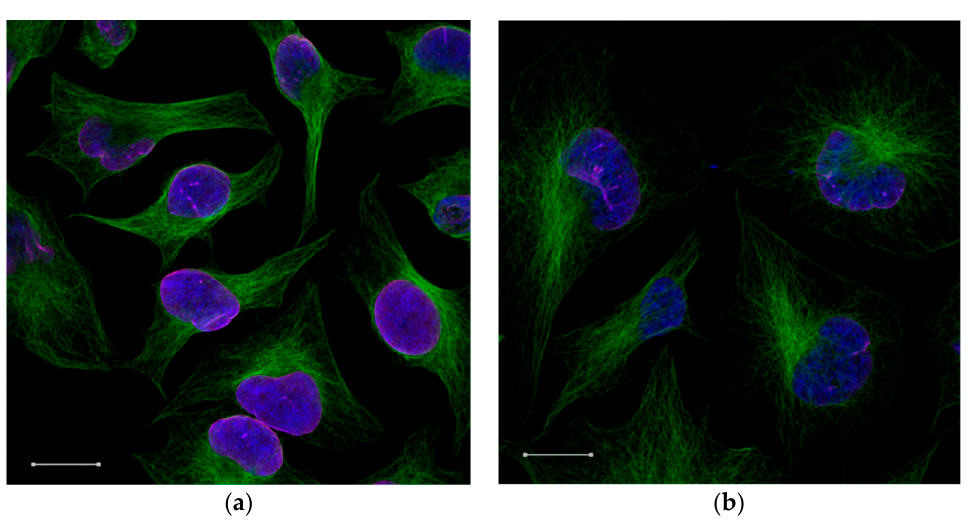
Figure 8. Fluorescent confocal laser scanning microscopic images were not able to observe the intracellular transport of siRNArod fluorescent incorporated in the MCM-41 + GPTMS + CS nanoparticles in HeLa cells. ( a ) Absence of cellular uptake of fluorescent rhodamine-siRNA-MCM-41 + GPTMS + CS in HeLa cells; ( b ) Absence of cellular uptake of fluorescent rhodamine-siRNA-MCM-41 + GPTMS + CS in HeLa cells in another field.